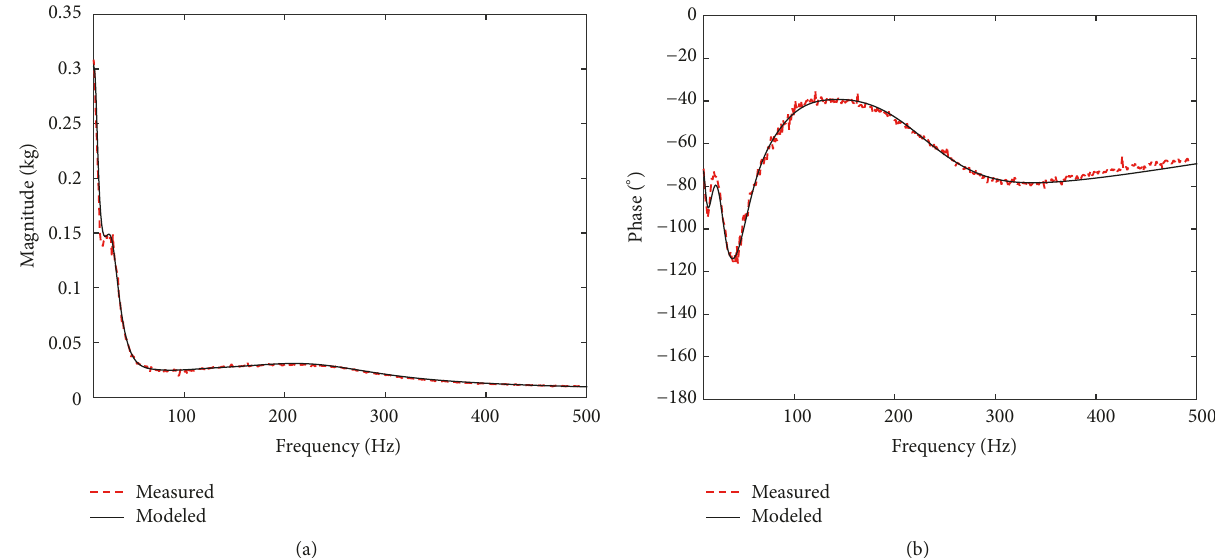
Figure 9: Comparison of the three-phalanx measurement and 3-Phalanx model apparent mass: (a) magnitude; (b)